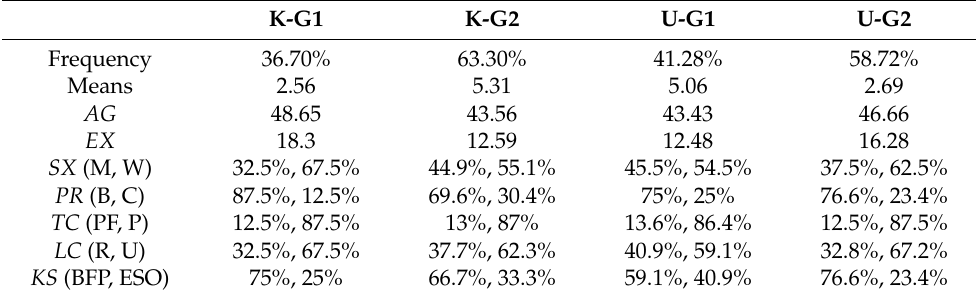
Table 11. Cluster groups as regards the knowledge and use of content creation tools (CCT).